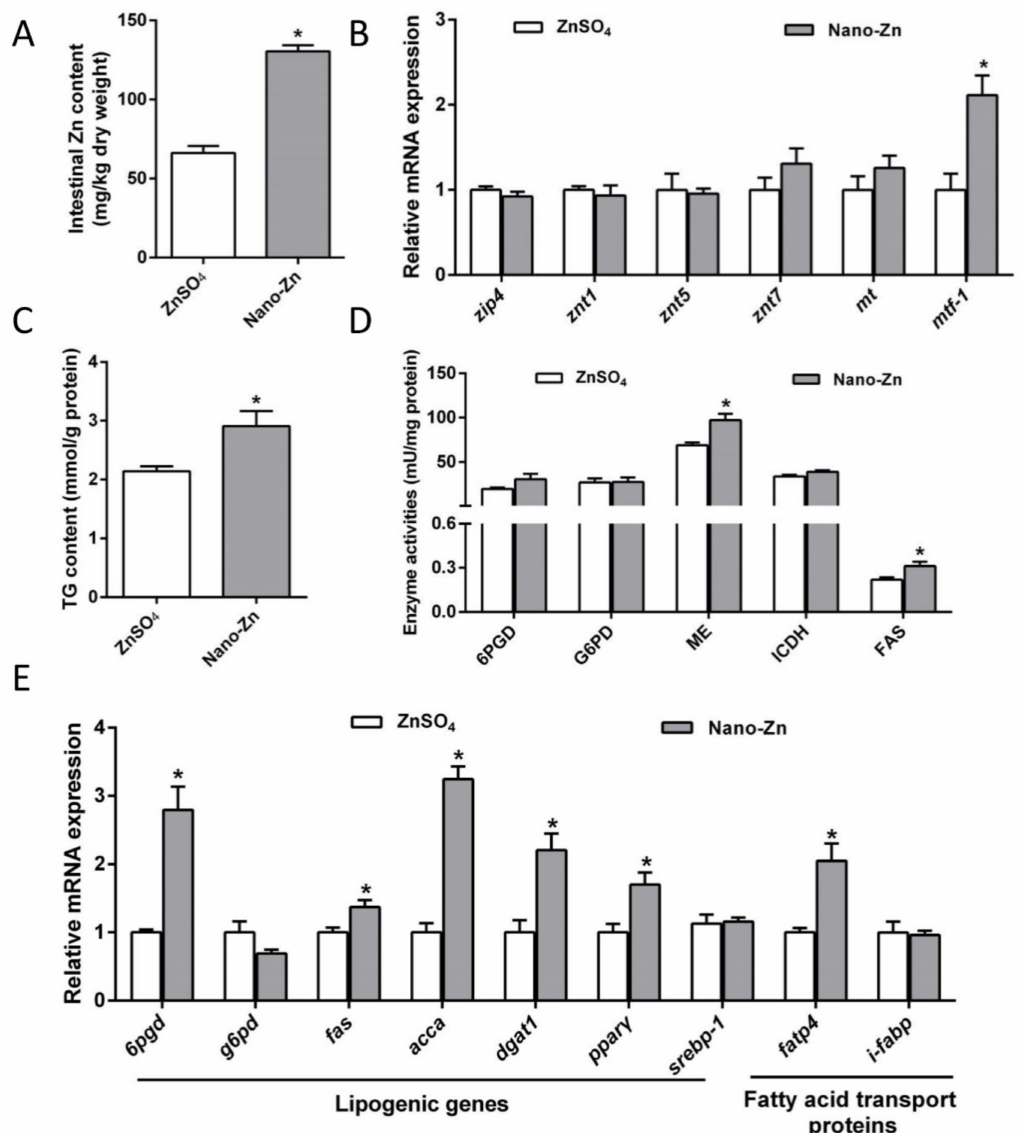
Figure 1. E ff ects of two Zn sources on Zn transport proteins and lipid metabolism of the intestine of yellow catfish. ( A ) Zn content. ( B ) The mRNA levels of Zn transport protein. ( C ) Triglyceride (TG) content. ( D ) Enzyme activities. ( E ) The mRNA levels of the lipogenic genes. Values indicate means ± SEMs, n = 3. The mRNA levels of genes from the ZnSO 4 group were considered to be 1. Asterisks ( ∗ ) indicate significant di ff erences between ZnSO 4 and the nano-Zn group ( p <